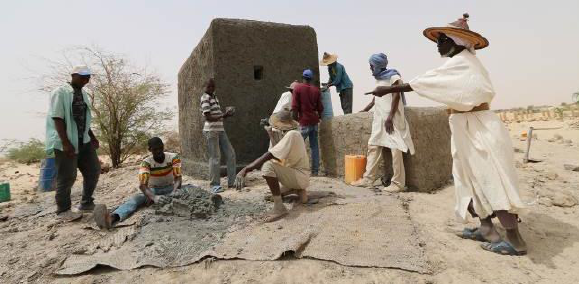
Figure 6. Preparation of mortar for plastering by young masons supervised by the head of the masons’ corporation. Mausoleum